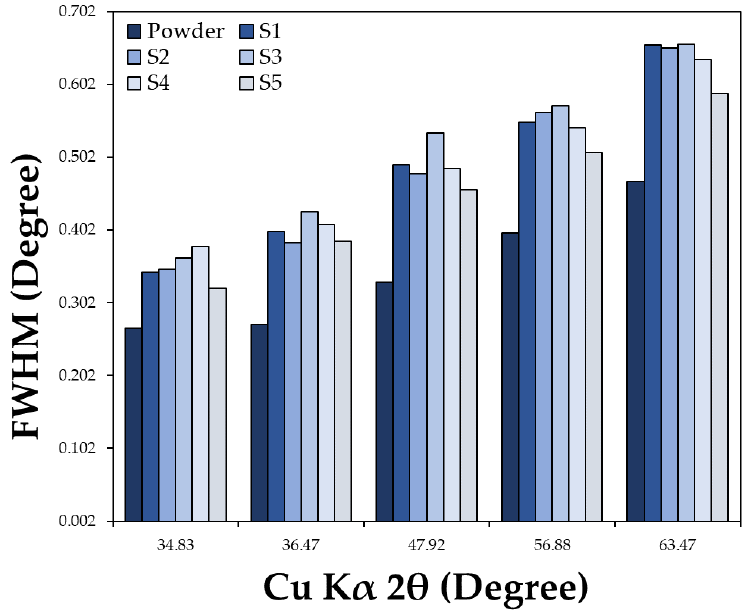
Figure 9. A comparative analysis of the calculated major FWHM peaks of CS Zr coatings.